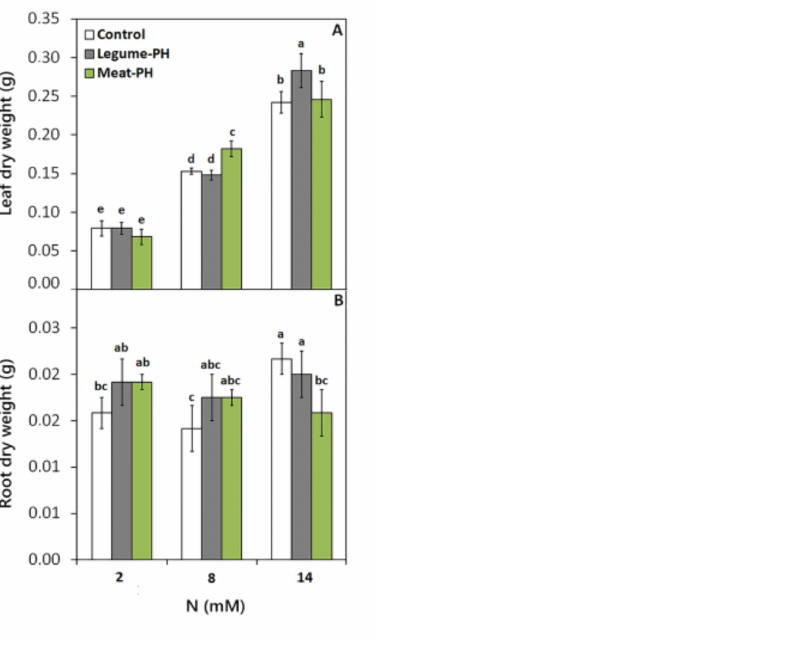
Figure 2. Effect of nitrogen doses and foliar application of biostimulants on the dry weight of leaves ( A ) and roots ( B ) of spinach leaves. Vertical bars (standard error) ( n = 6) with different letters are significantly different according to the LSD test ( p =